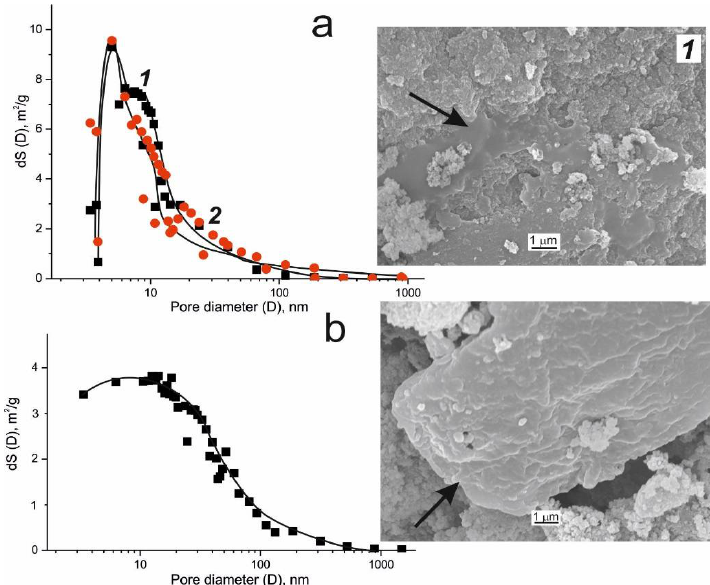
Figure 2. ( Left ) Pore size distribution: ( a ) baker yeast autolysates entrapped inside SiO 2 -xerogel without nanocarbon ( 1 , ) and with CNT1s ( 2 , ), ( b ) r E. coli /lip lysates entrapped inside SiO 2 -xerogel without nanocarbon. ( Right ) SEM images of cleavages of the lysate-based biocatalysts. Arrows indicate the smooth area corresponding to lysates entrapped in SiO 2 -xerogel.